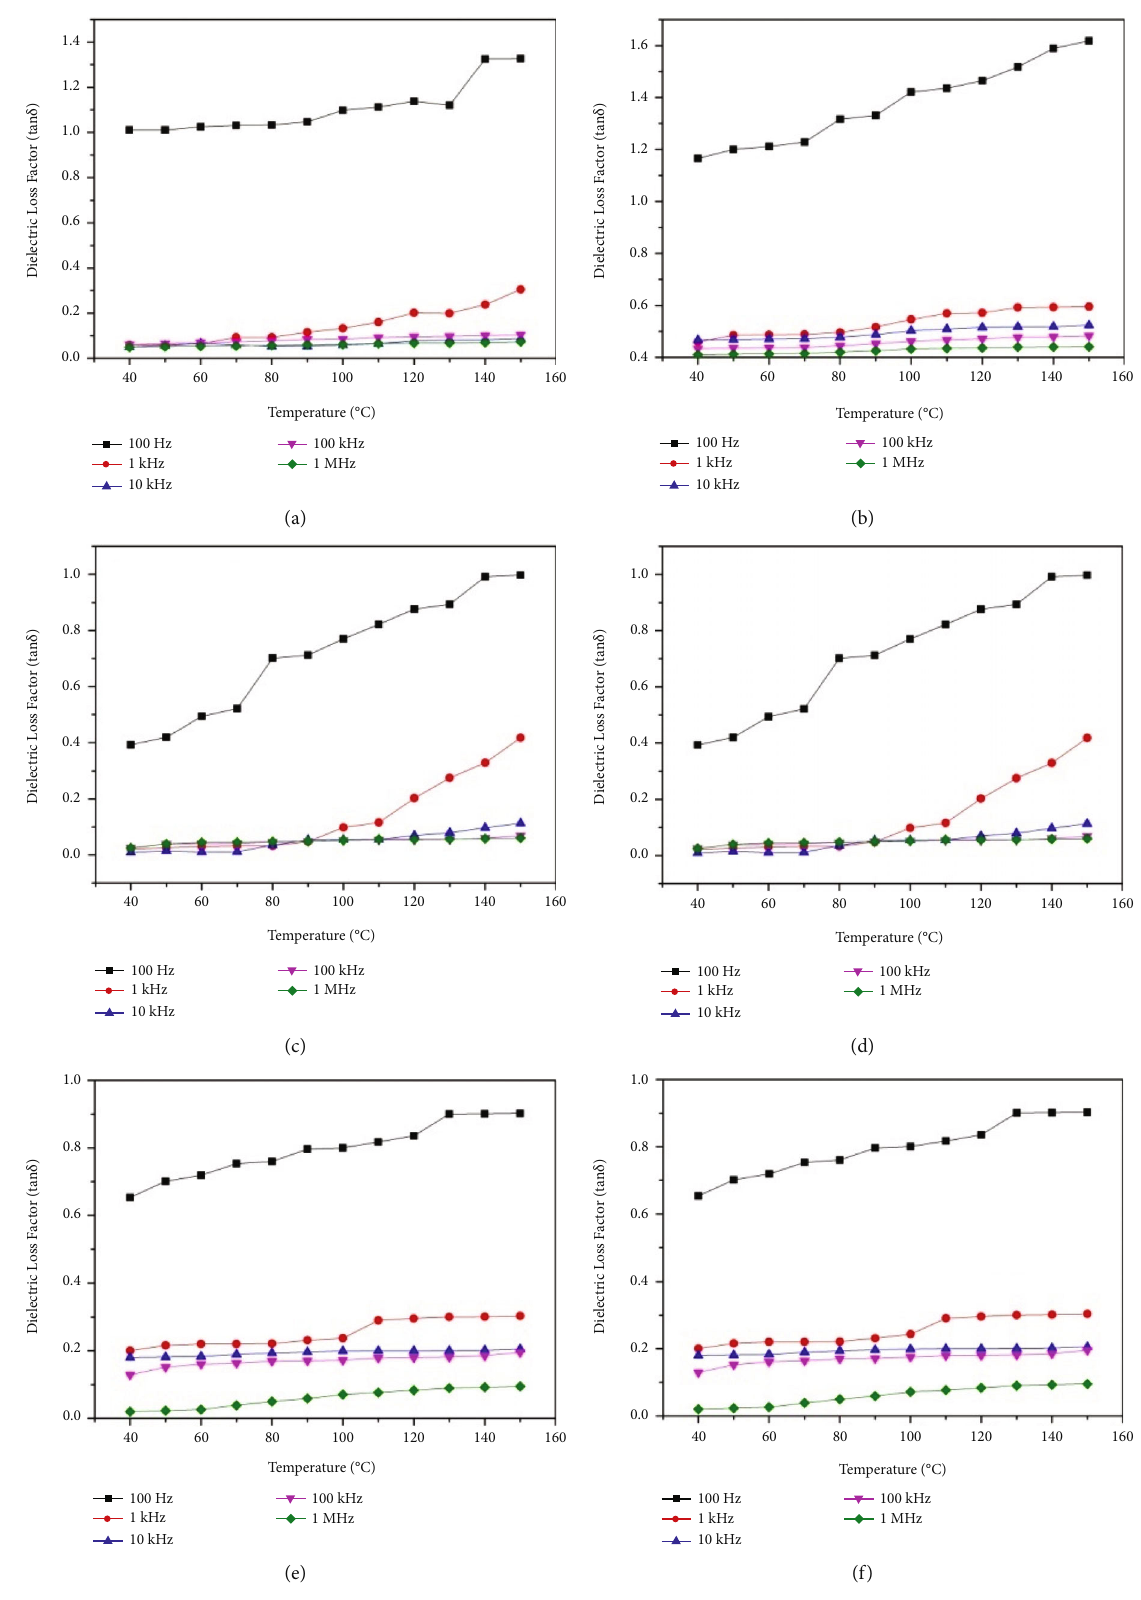
Figure 6: Dielectric loss factor as a function of temperature and frequency for (a) sample A, (b) sample B, (c) sample C, (d) sample D, (e) sample E, and (f) ample